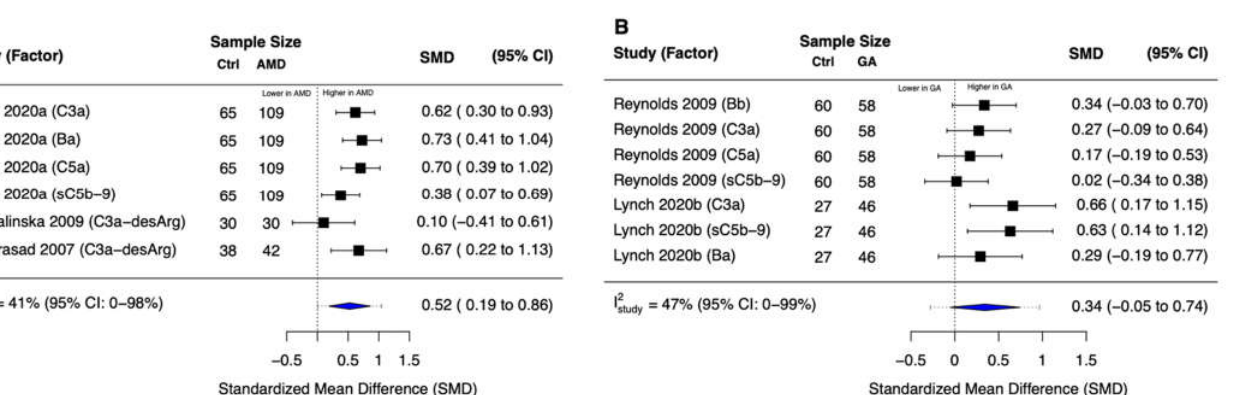
seven effect sizes from two studies revealed that the difference in the systemic levels of complement common final pathway activation products in patients with GA (N = 104)